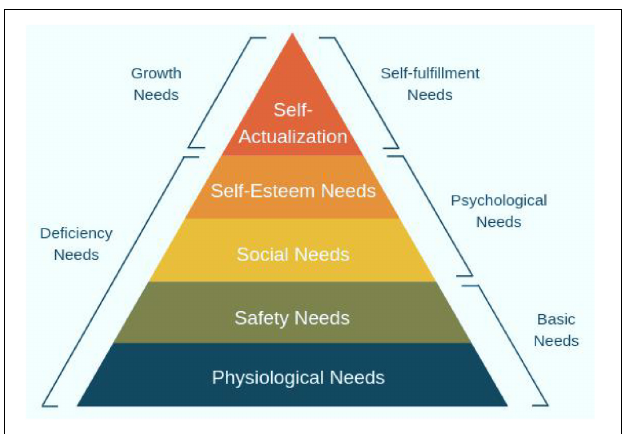
FIGURE 1 | The hierarchy of needs theory (Maslow,